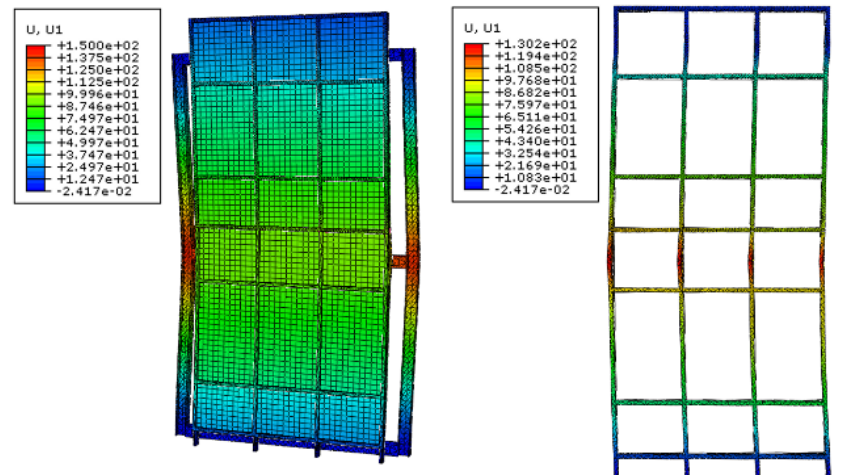
Figure 18. Response of the conventional curtain wall under static lateral drift.